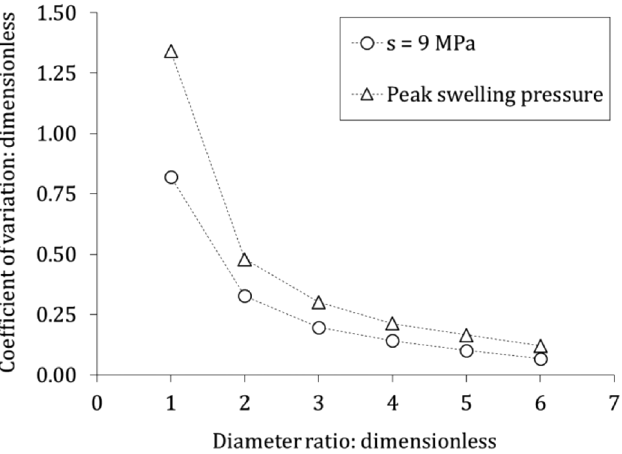
Fig. 9. Calculated coef fi cient of variation of the swelling pressure as a function of the ratio of pressure sensor diameter to initial pellet